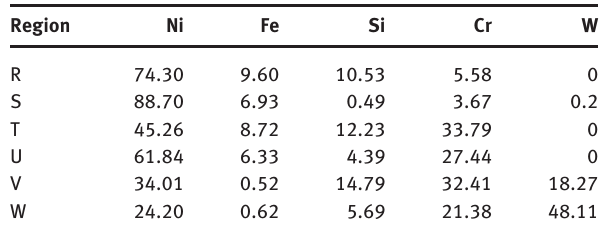
Table 3: Characteristic element composition of coating fracture